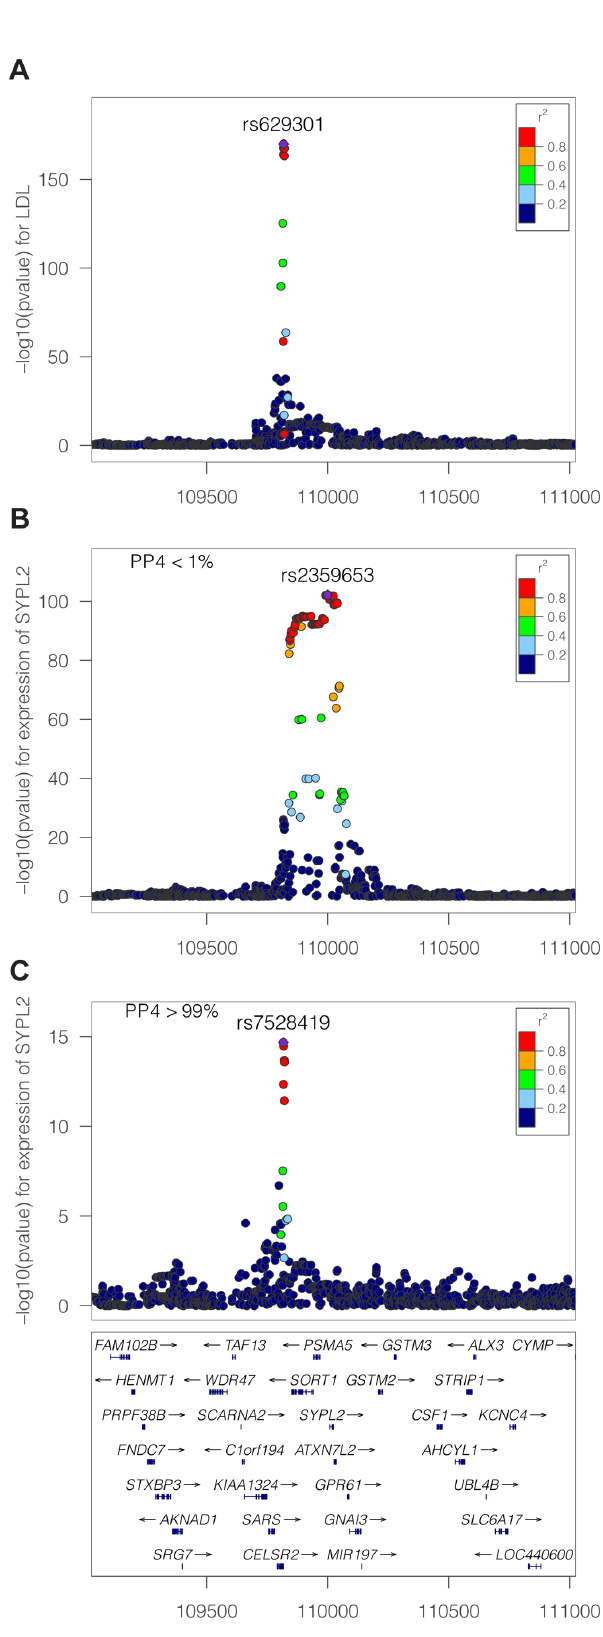
Figure 6. LDL association and eQTL association plots at the SYPL2 locus. The x-axis shows the physical position on the chromosome (Mb) A : -log10(p) association p-values for LDL.